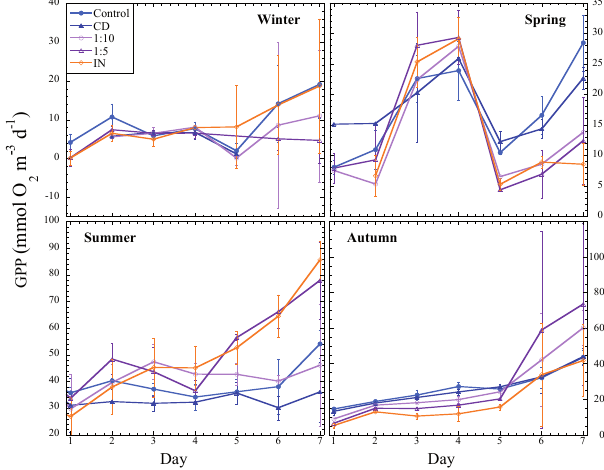
Figure 2. Gross primary production (GPP) in mmol O 2 m − 3 d − 1 measured the seven incubation days for the different treatments and experiments.